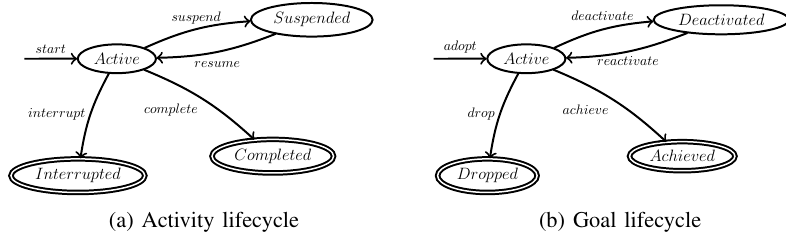
Fig. 2: Lifecycle of an activity and a goal. Double ellipses represent terminal states.